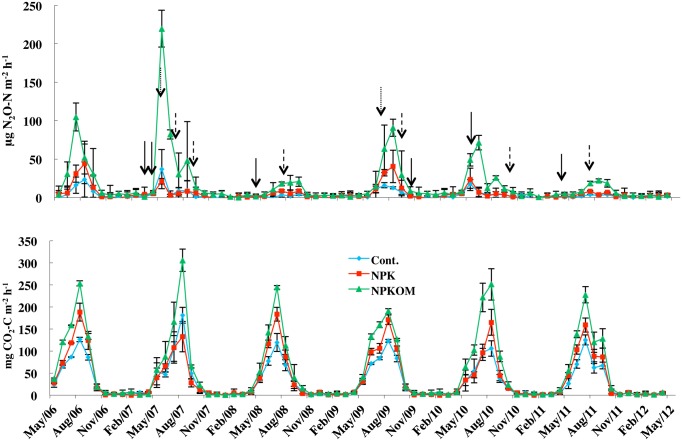
Average hourly N2O and CO2 fluxes in three fertility management treatments.The monthly average soil-to-atmosphere N2O and CO flux in control (Cont. no fertilizer applied), chemically fertilized (NPK) plots, and plots receiving chemical fertilizer and composted pig manure (NPCOM) in the corn-soybean-wheat rotation from May 2006–April 2012. Line bars indicate standard errors (n = 3). Vertical arrows indicate dates of planting (solid lines), harvest (dashed lines) and supplemental fertilizer application (dotted lines).